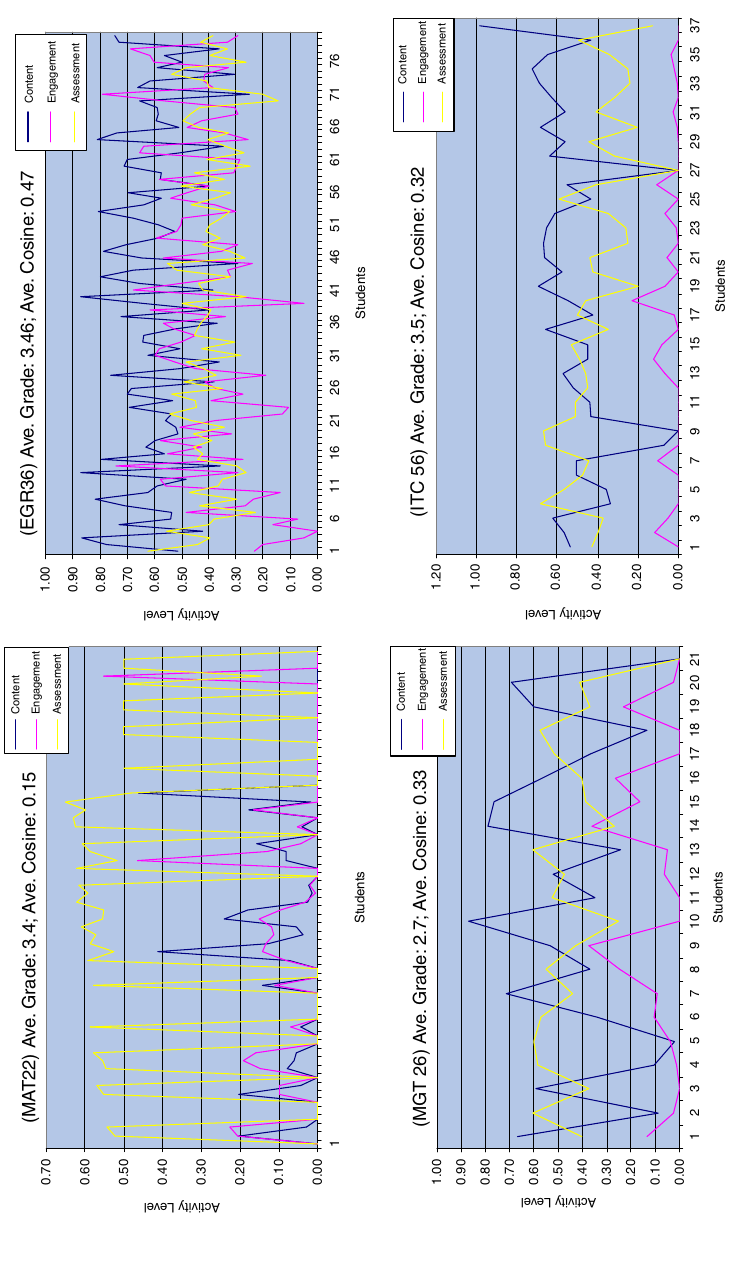
Figure 5. Visualization of class activity based on action logs